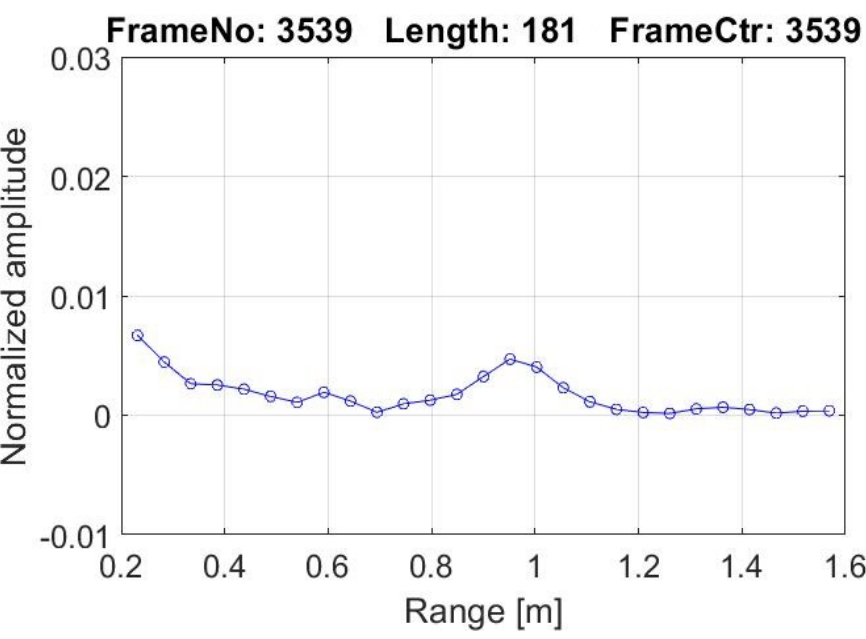
Figure 2. Plot of signal during data collection.